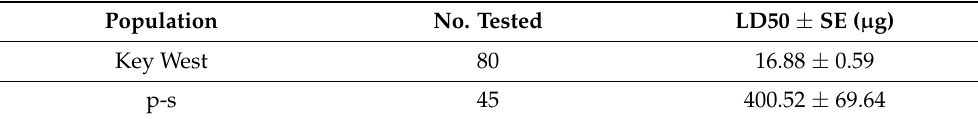
Table 2. Toxicity of permethrin between the Ae. aegypti populations.